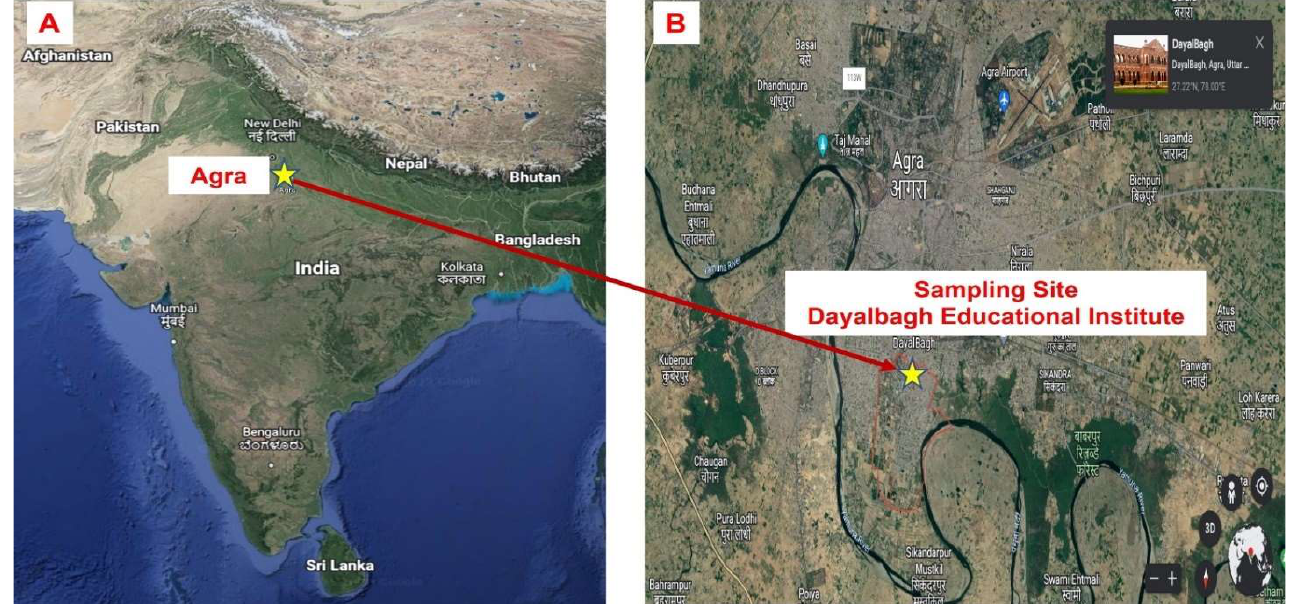
Figure 1. ( A ) Location of Agra in Map of India, and ( B ) Sampling site (Dayalbagh Educational Institute, Agra) in the IGP.